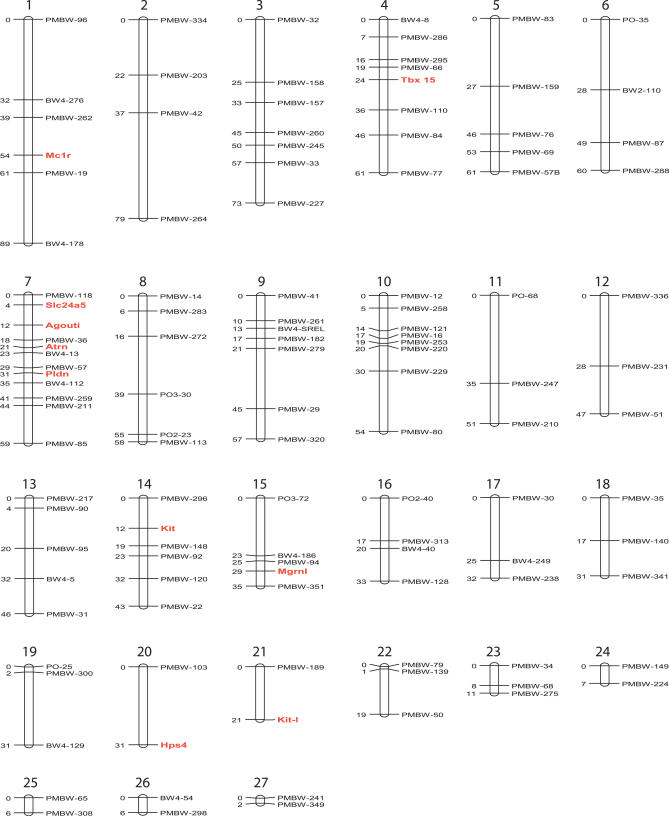
A Genome-Wide Linkage Map of P. polionotus Comprising 27 LGs Ordered by SizeMicrosatellite loci are indicated in black and candidate pigmentation genes in red. The cumulative genetic distance between markers is given in centimorgans (cM). All candidate genes were on separate LGs with the exception of Pldn, Atrn, Slc24a5, and Agouti, which clustered on LG 7. A total of three microsatellite loci and one pigmentation gene Tyr failed to show linkage to any other markers.